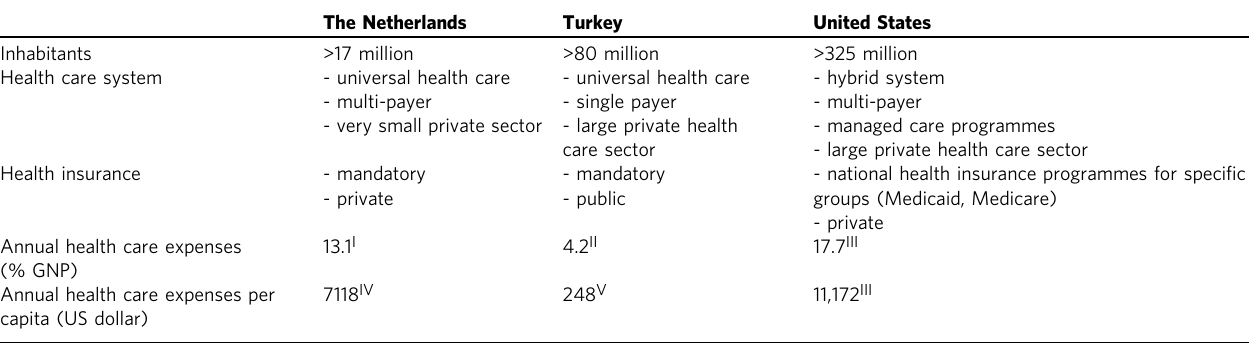
Table 1 Some characteristics of healthcare systems in the Netherlands, Turkey and the United